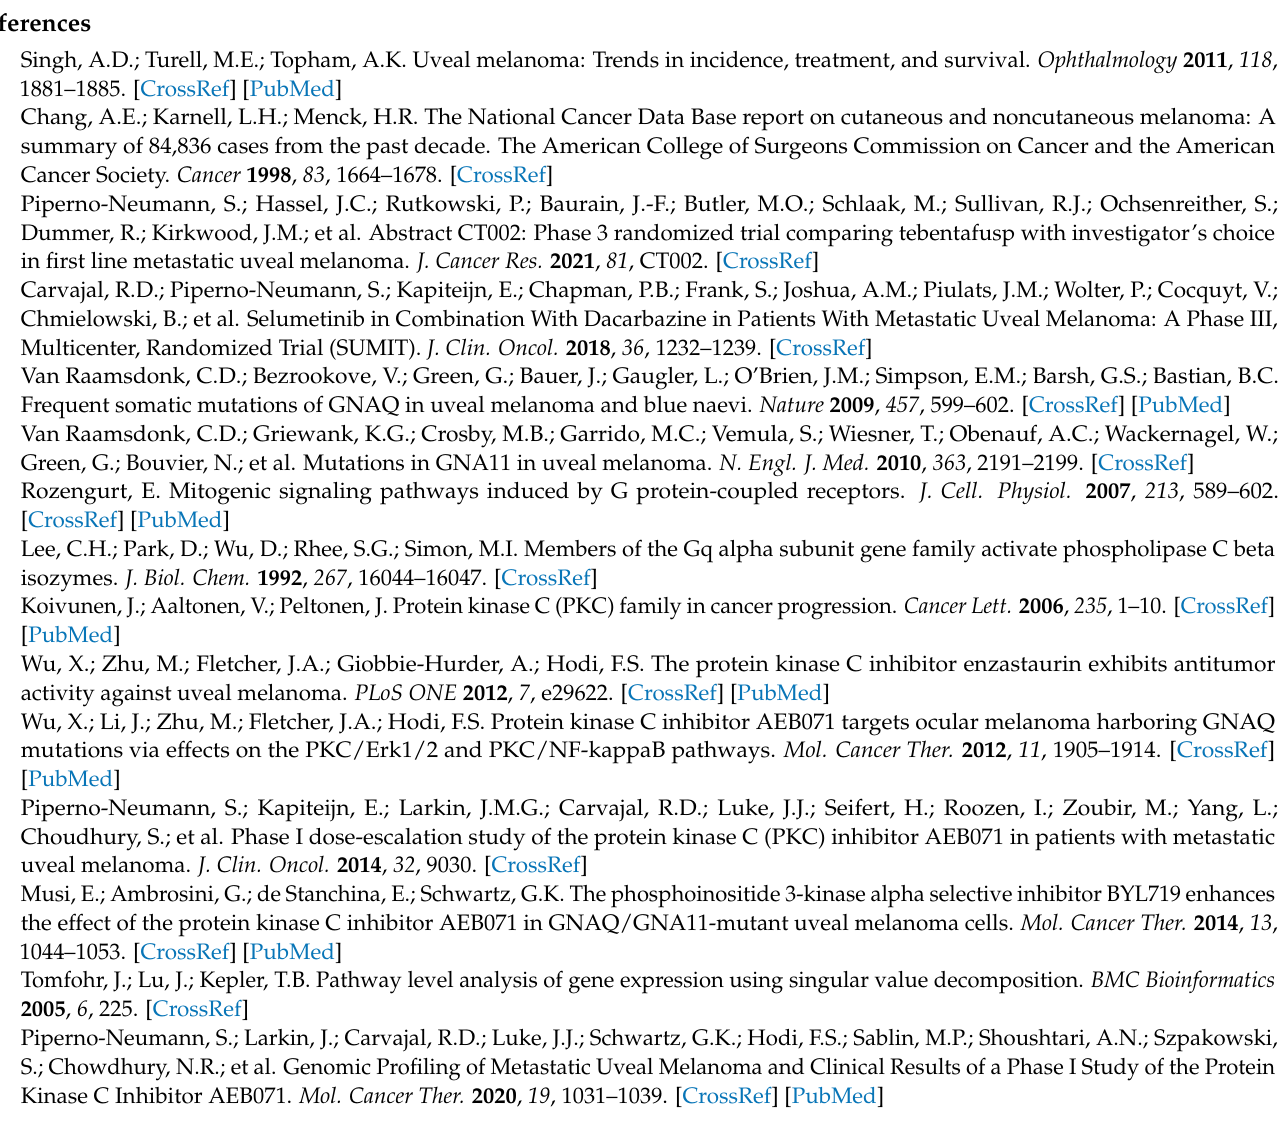
Figure A2. Supplemental Western blot analyses for potential markers of cell proliferation, apoptosis, and metabolic activity. Paired tumor biopsies were assessed by western blot for Cyclin E1, D1, A2, Bcl-2, and GLUT4. GAPDH was used as a loading control.